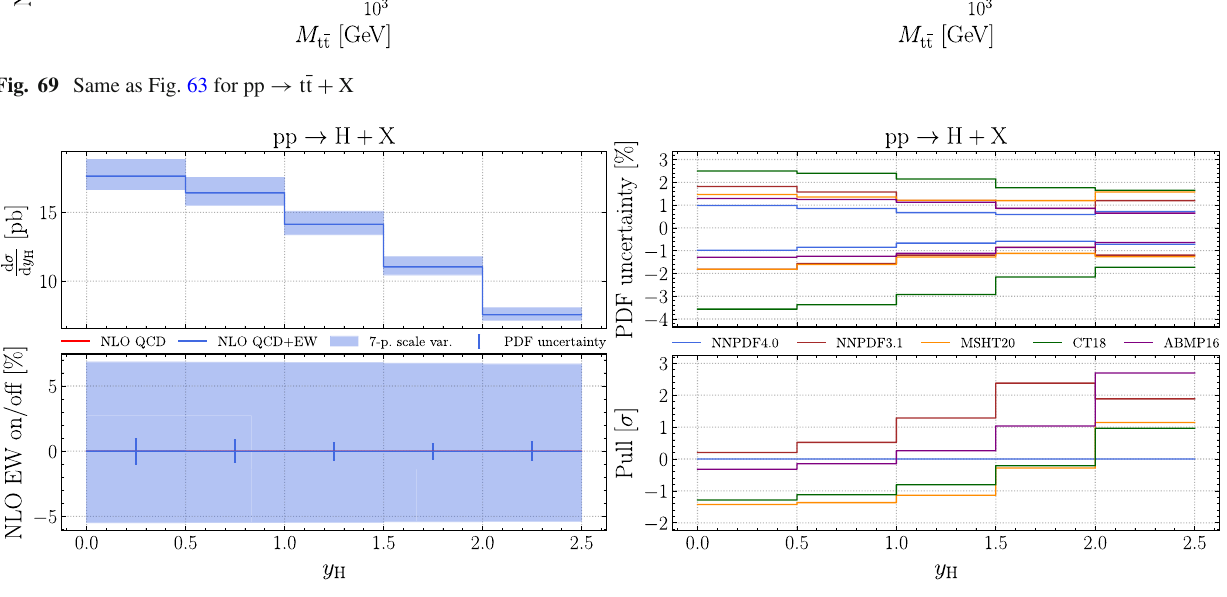
Fig. 70 Same as Fig. 63 for pp → H +